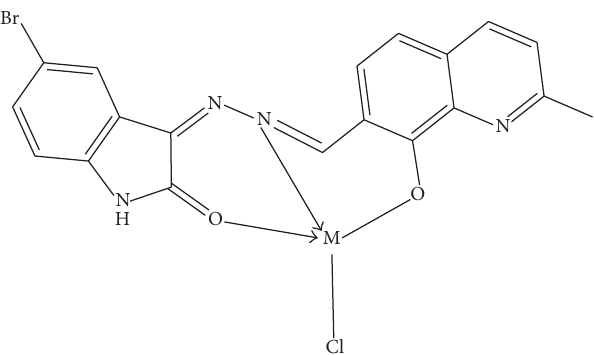
Figure 7: Proposed structure of Zn(II), Cd(II), and Hg(II) metal complexes